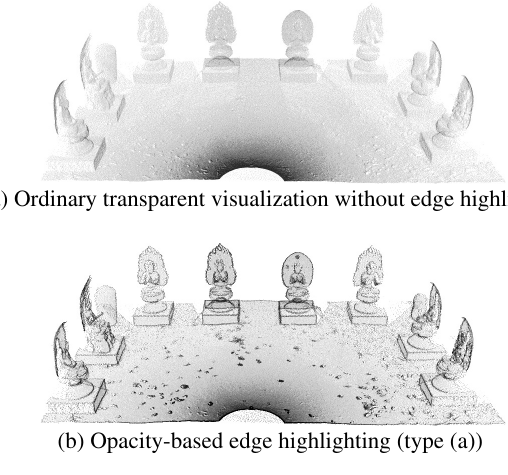
Figure 9. Comparative visualizations of the prayer chapel in the Zuiganji Buddhist Temple (2): viewpoint inside the chapel.